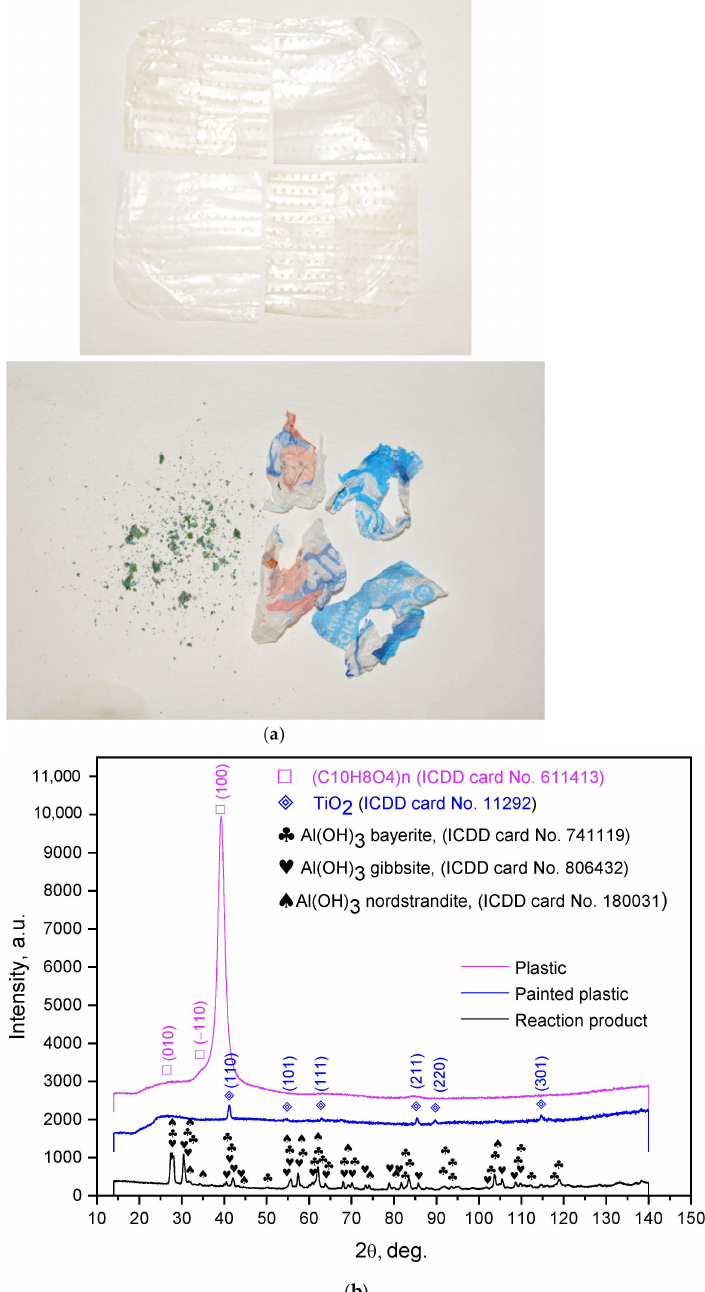
Figure 10. Characterization of the remaining sample components: ( a ) general view (residual plastic pieces: PET—left; painted PE—right); ( b ) XRD patterns for the remaining